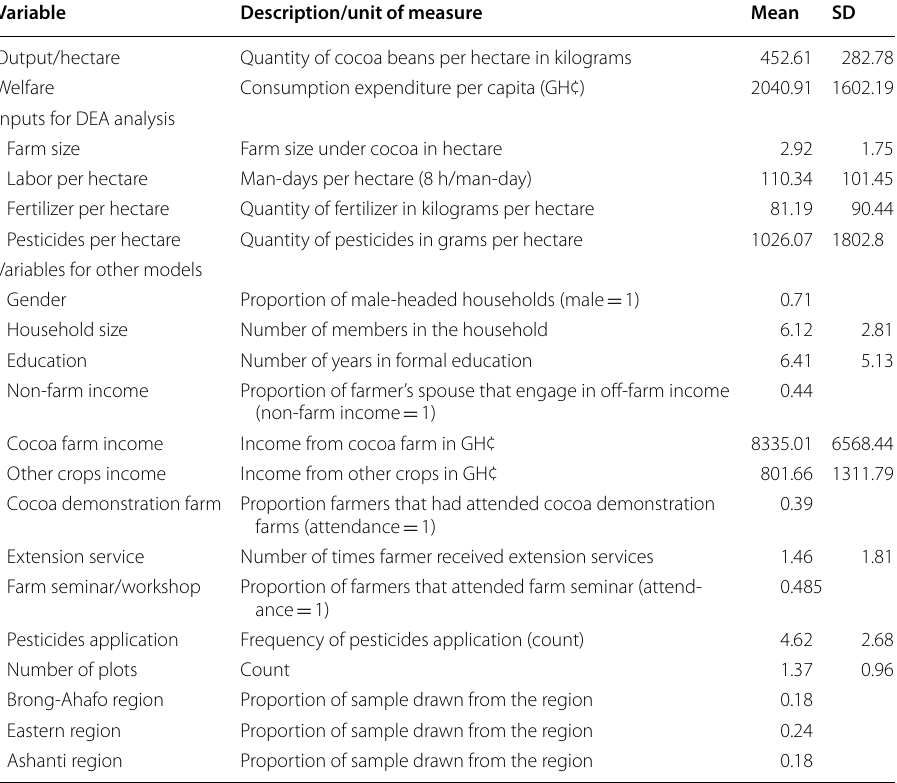
Table 1 Descriptive statistics of variables used in the models